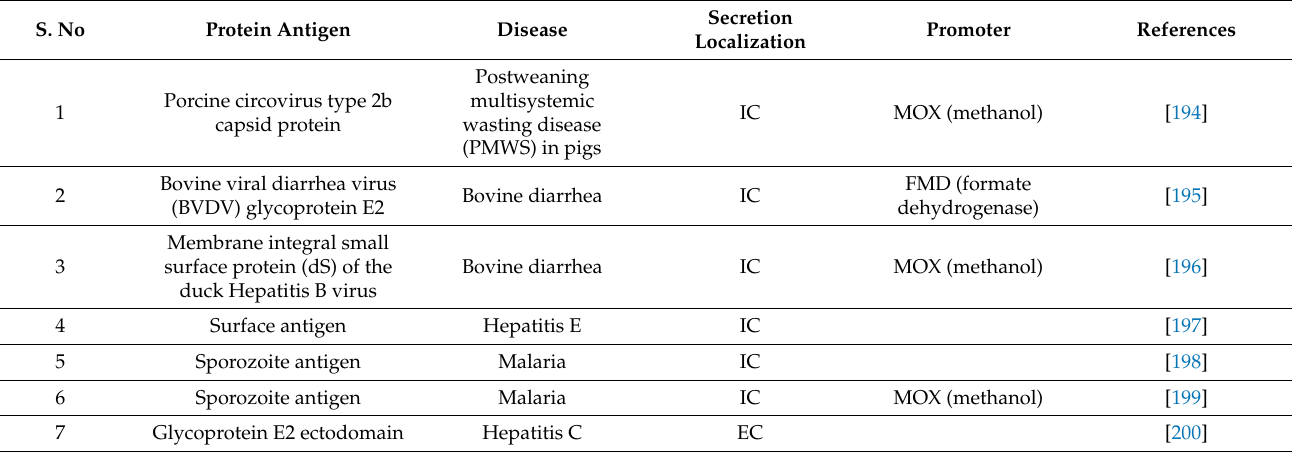
Table 4. Studies where H. polymorpha yeast was used to generate VLPs.